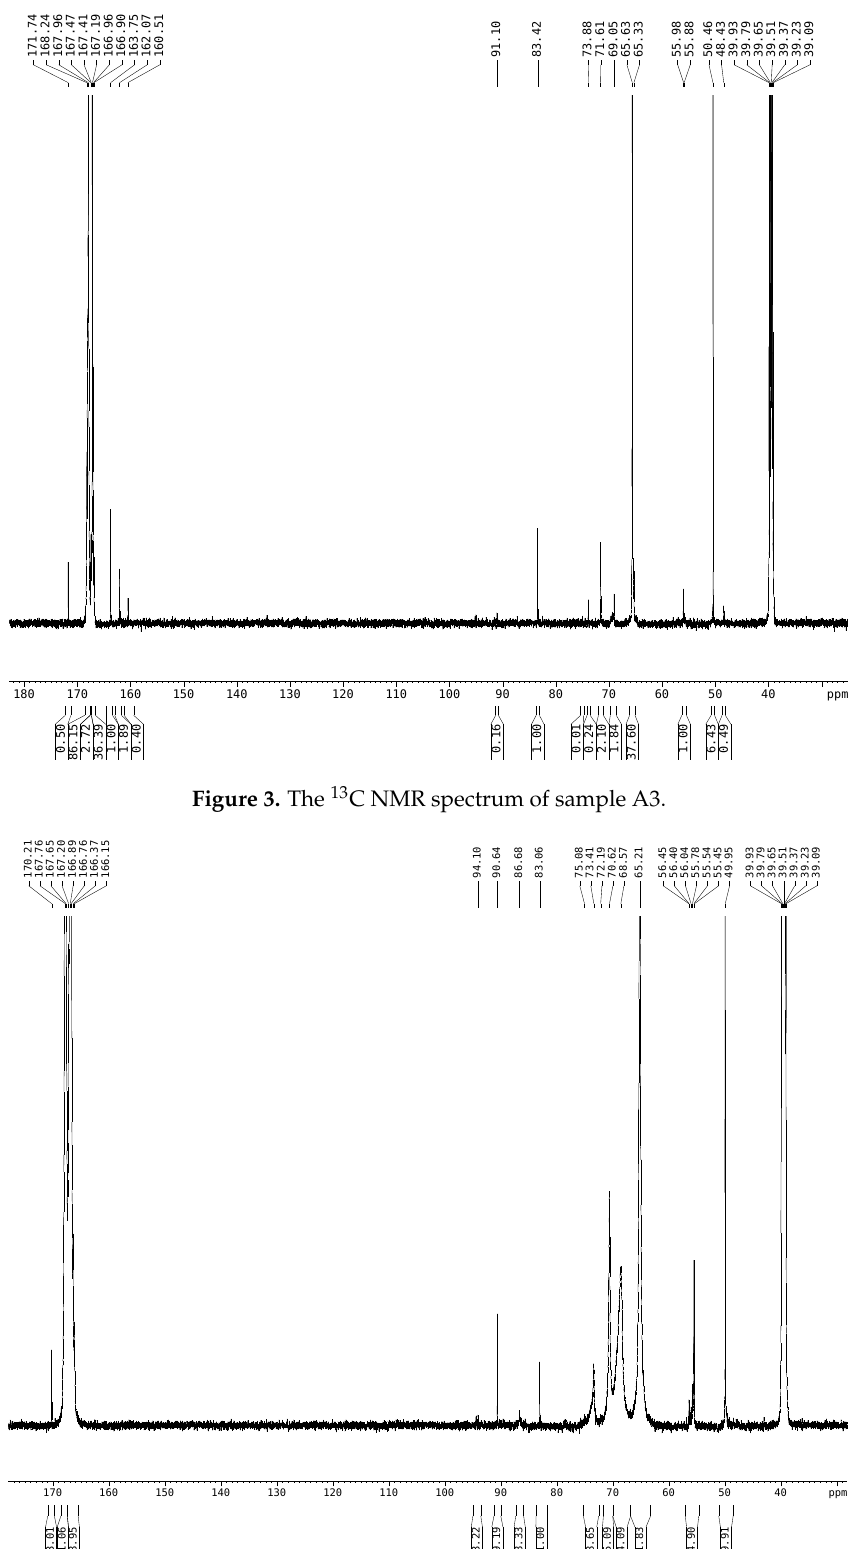
Figure 4. The 13 C NMR spectrum of sample